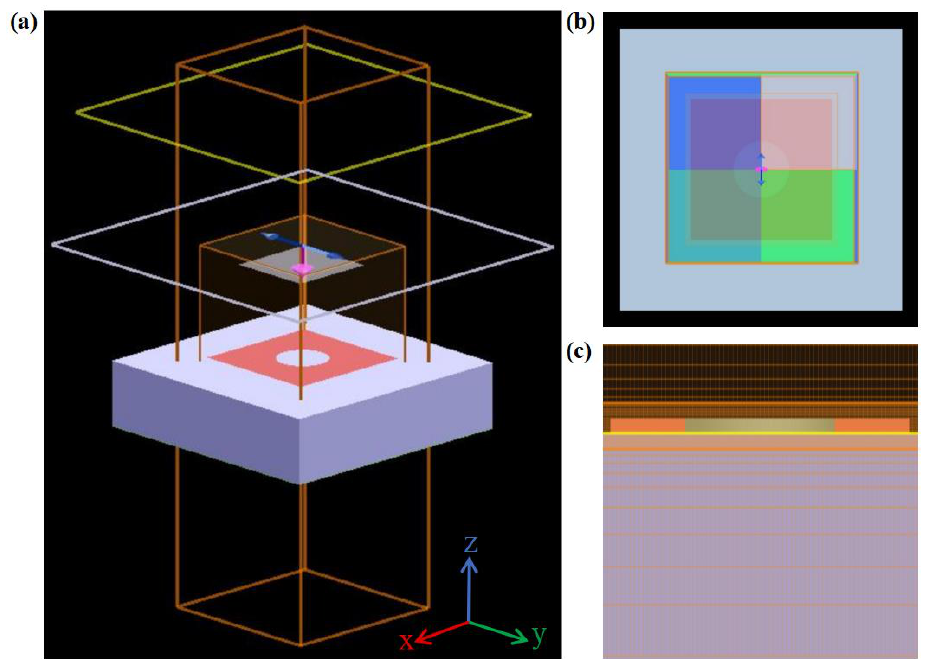
Figure 3. FDTD simulation of the designed absorber. ( a ) Perspective view of the absorber; ( b ) view of the x-y plane; ( c ) part view of the y-z plane (the selected part here is to display the mesh grid clearly). The absorption can be expressed as A ( ω ) = 1 − T ( ω ) − R ( ω ) , in which T ( ω ) repre- sents the terahertz transmission, and R ( ω ) represents the terahertz reflection. In addition, both T ( ω ) and R ( ω ) can be expressed in terms of S-parameters as T ( ω ) = | S 21 | 2 and R ( ω ) = |S 11 | 2 , respectively, where S 21 and S 11 are the complex transmission coefficient and reflection coefficient, respectively. Because the substrate is metal, which can prevent the downward transmission of a terahertz wave, T ( ω ) = 0 can be acquired. The absorption can then be simplified as A ( ω ) = 1 − R ( ω ) = 1 − | S 11 | 2 . Considering the impedance